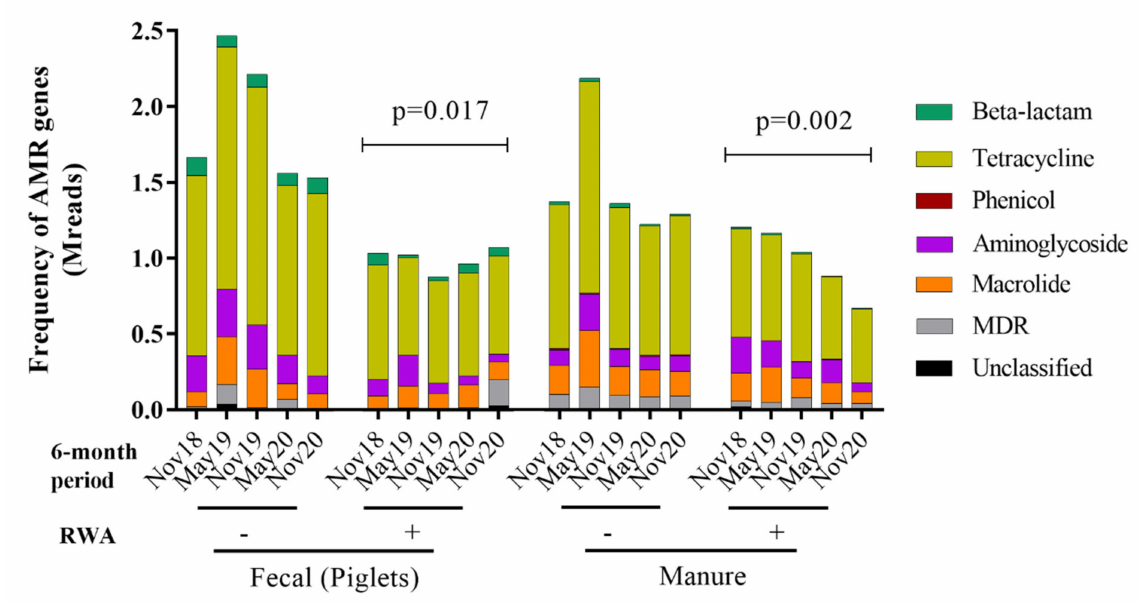
Figure 4. Metagenomic resistome showing the frequency of antibiotic resistance genes (ARGs) clustered into 6 classes— tetracycline, aminoglycosides, macrolides, phenicol, β -lactams, and multi-drug resistance (MDR)—and collected from non-RWA − (minus sign) and RWA + (plus sign) piglet feces and barn manure samples.